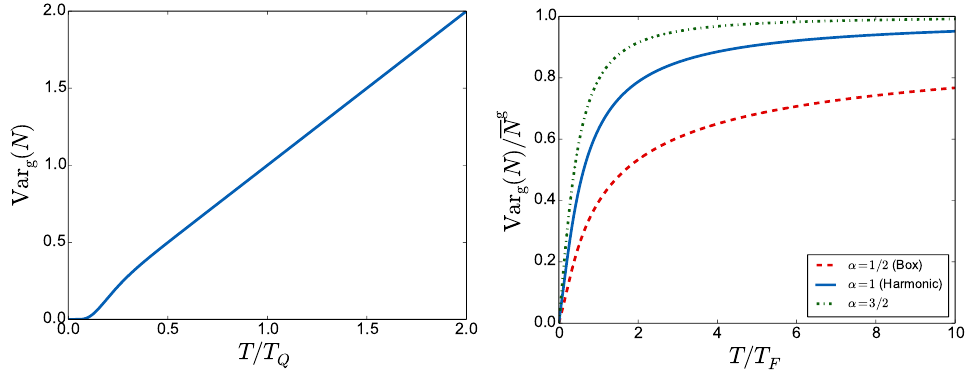
Figure 4: Variance of the total number N of fermions in the grand canonical ensemble, as a function of the temperature T . Left: quantum regime T ∼ T obtained from (141). This Q function is universal. Right: thermal regime T ∼ T , given by Eq. (151) for different types of F confinment: α = 1 (harmonic), α = 1 / 2 (infinite well) and α = 3 / 2. These two relations (150) and (151) allow to plot this variance for different confining poten- tials, corresponding to different values of α , see Fig. 4, right. In the high-temperature limit, the variance reaches the classical